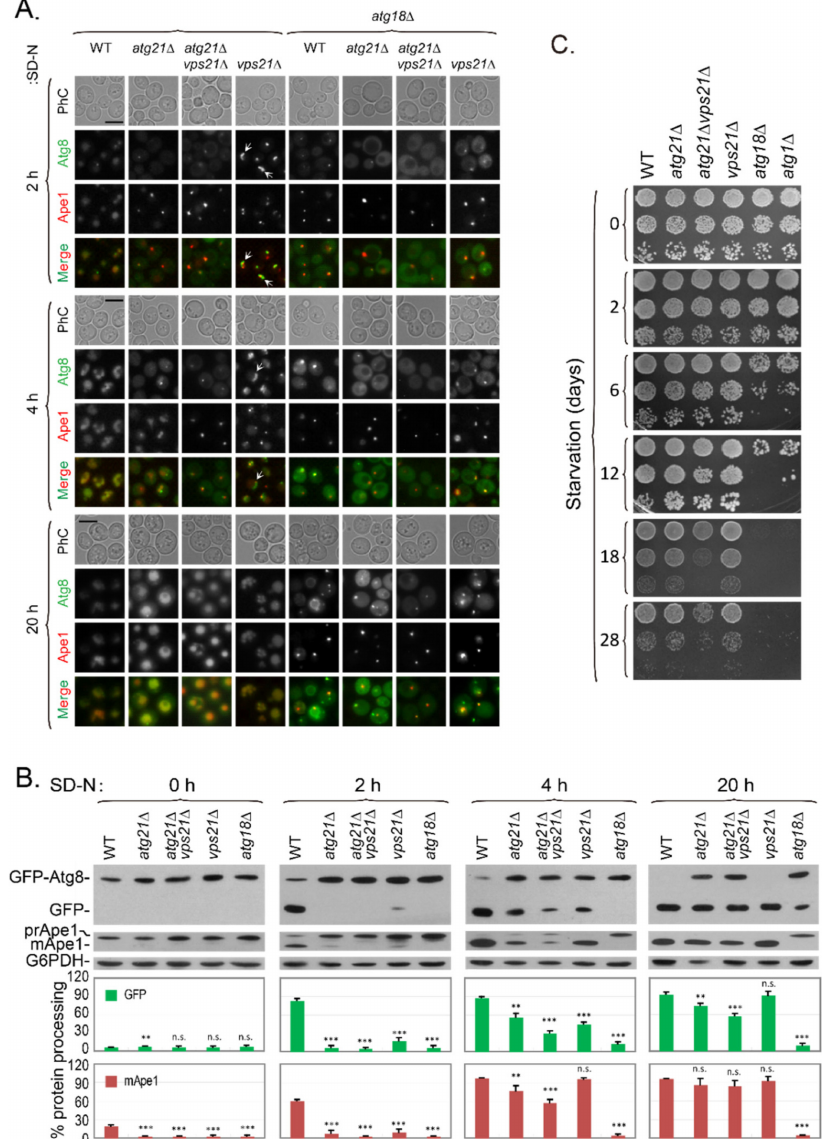
Figure 8. Vps21 and Atg21 synergistically regulate autophagy under nitrogen starvation. ( A ) GFP- Atg8 and RFP-Ape1 localizations were synergistically regulated by Atg21 and Vps21 under nitrogen- starvation conditions. The indicated strains were grown in YPD medium to mid-log phase and starved in SD-N medium for different durations, and GFP-Atg8 and RFP-Ape1 localizations were then observed. Strains with an atg18 ∆ background were used as controls for the atg21 ∆ strains. The arrows indicate autophagosomal clusters (APCs). Scale bars, 5 µ m. ( B ) Immunoblotting assays indicated that GFP-Atg8 degradation and prApe1 maturation were synergistically regulated by Atg21 and Vps21 under nitrogen-starvation conditions. Anti-GFP and anti-Ape1 antibodies were used to assess GFP-Atg8 degradation and prApe1 maturation, respectively. G6PDH served as a loading control. The immunoblotting bands were quantified, and the mean ± SD are presented graphically below the bands. Significant differences are indicated with p -values in comparison to the WT strain: n.s., not significant; **, p < 0.01; ***, p < 0.001. ( C ) Growth assays for strains after different durations of nitrogen starvation indicated that Atg21 and Vps21 synergistically regulated autophagy. The main strains in panel ( A ), as well as an additional atg1 ∆ strain, were grown in YPD medium to mid-log phase and then starved in SD-N medium for different durations. The starved cells were washed with sterilized water, spotted onto YPD plates, and grown for 3 days. The results shown are representative of those from least two independent